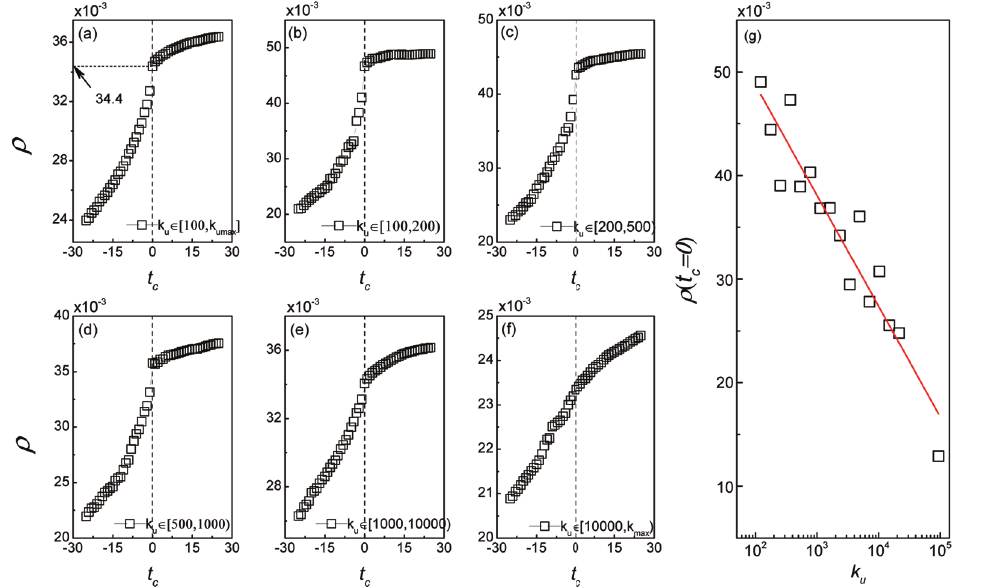
Fig 2. The dynamics of the overlap rate ρ before and after the creation of trust relations. The trust relation creation time is regarded as time t c = 0. (a) The growth of overlap rate ρ goes increasingly rapid before time t c = 0, while it will grows smoothly after the trust formation. The different growth patterns of the overlap rate ρ before and after time t c = 0 imply that, it is the accumulation of the common interests among users results in the trust formation, and not the reverse. (b)-(f) The detailed results of the dynamics of overlap rate ρ , in which the users are divided by their degrees into different groups, where the users ’ degrees are in ranges [100, 200), [200, 500), [500, 1000), [1000, 10000) and over 10000 respectively. The dynamics of the overlap rate exhibit similar trend in form for different user groups except the one with the user degree (cid:3) 10000. (g) For each pair of users, saying user u and user v , when user u trusts user v , the overlap rate ρ will decrease as the user degree k u